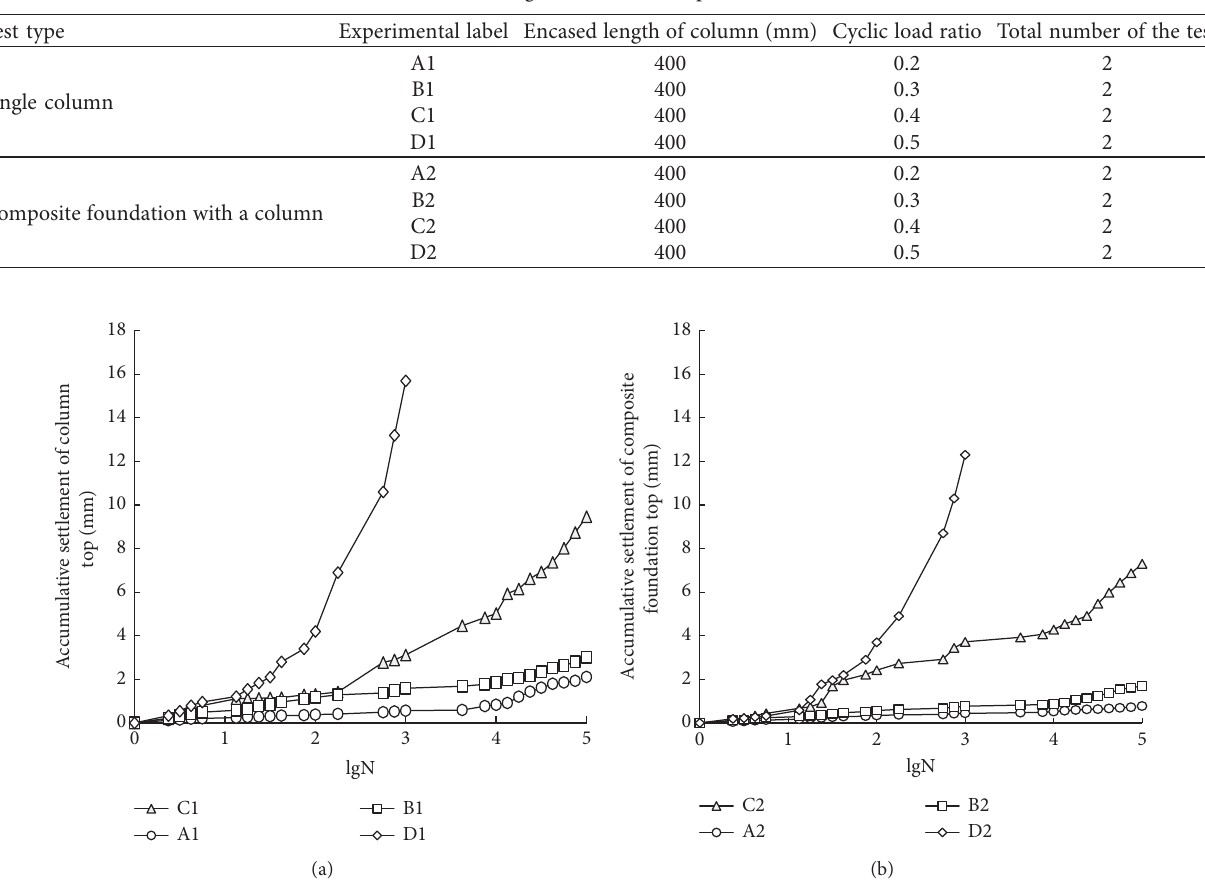
Figure 7: Settlement at the top: (a) single column; (b) single column composite